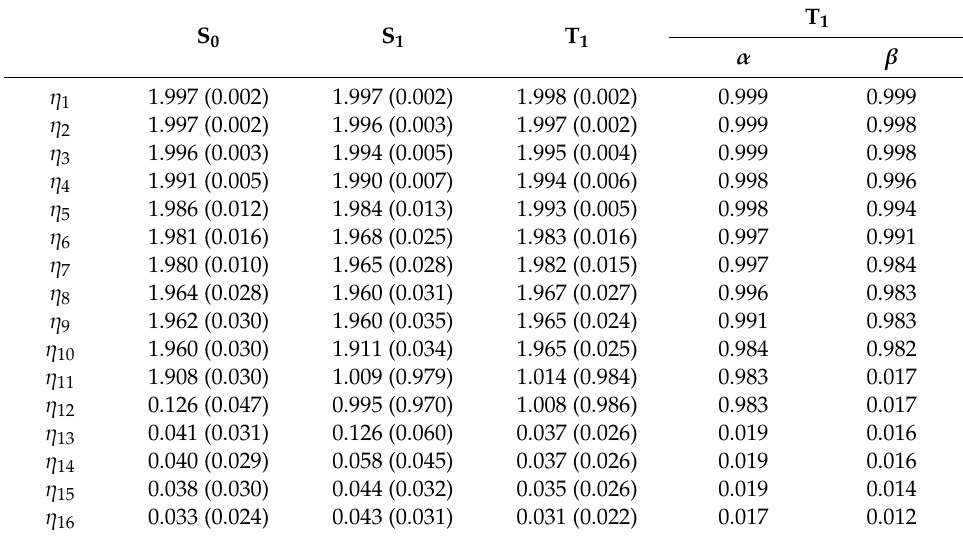
Table 3. Active-space NO occupation numbers for the S 0 , S 1 and T 1 states of S 2 N 2 and active-space NSO occupation numbers for the T 1 state (all in descending order). Values in brackets show the net contributions from all determinants in which a particular NO is singly